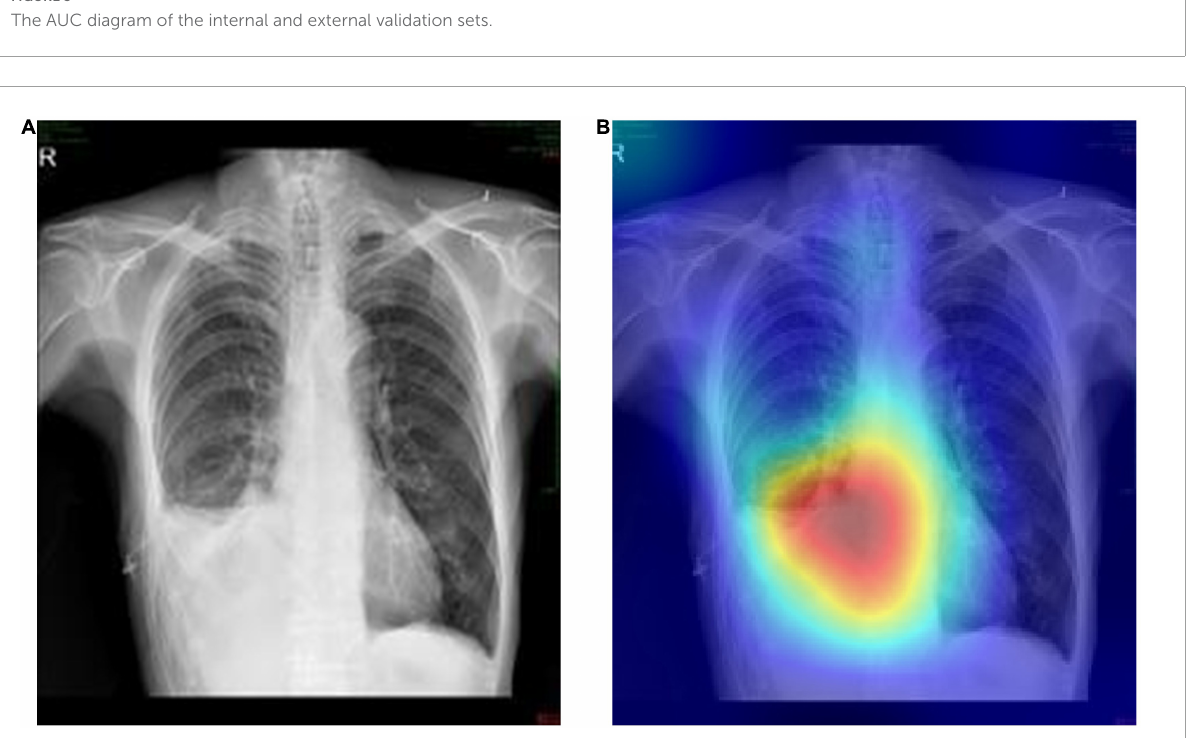
FIGURE6 Representative cases in the external testing sets. (A) Example of a true-positive case, that is the original chest radiograph of atelectasis with pleural effusion in ICUs. (B) Grad-CAM heatmap of class activation derived from model prediction classification.